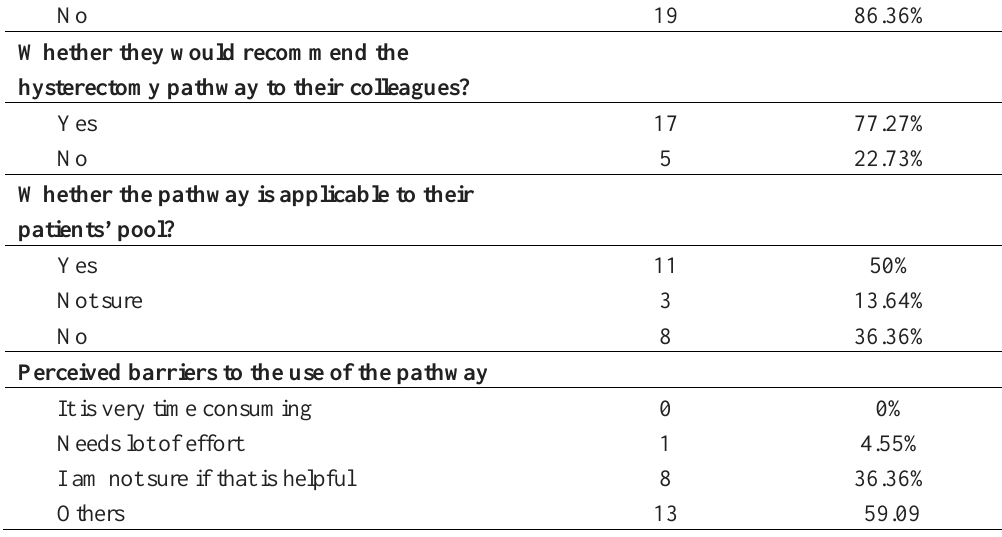
Table 1. Respondents’ evaluation of the clinical hysterectomy pathway are the ones who should make the final decision, and 2 (10%) said it should be a shared decision between them and their obstetrics and gynecology